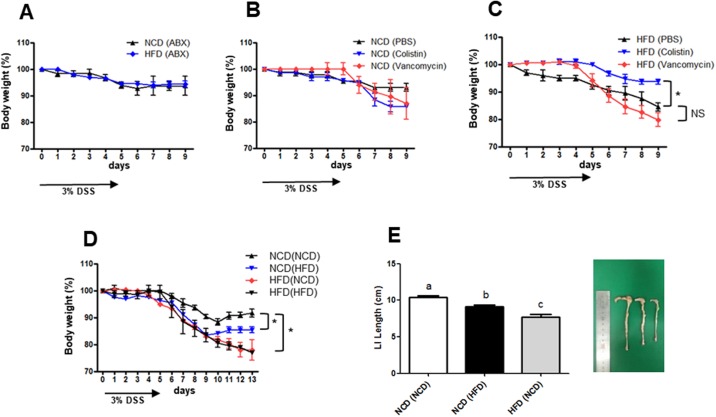
Fecal microbial transplantation (FMT) and antibiotic treatment alter colitis progression.(A-C) Antibiotic treatment. Mice were fed normal chow diet (NCD) or high-fat diet (HFD), and an antibiotic combination (A) or a single antibiotic (B and C) was administered for 8 weeks. Subsequently, DSS-colitis was induced. (D-F) Effects of FMT. NCD- or HFD-fed mice gavaged with fecal material from the same or the other group were treated with dextran sodium sulfate (DSS) and monitored for colitis development. Body weight is presented as the percentage of the initial weight (D). Colon lengths on day 13 of DSS treatment (E, left). Images of representative colons (E, right). (n = 5 each). *P < 0.05. All values are expressed as the means ± SEM. A student’s t-test was used to compare values between two groups. A one-way ANOVA was used to compare values among multiple groups. If an ANOVA test showed significant differences, the Duncan post-hoc test was used to compare two specific groups. If the Duncan test did not show a significant difference (P > 0.05), the two groups were labeled with the same letter over the respective bars. P values < 0.05 were considered statistically significant. *P < 0.05 (n = 5 each). NS, not significant.